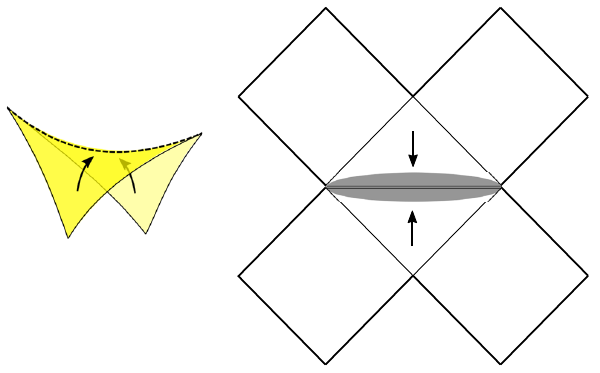
Fig. 8 Annihilation-to-nothing interpretation. Left: two black hole phasescollideandareannihilated.Right:physicalarrowsoftimecanbe flipped around the quantum gravitational region (gray colored